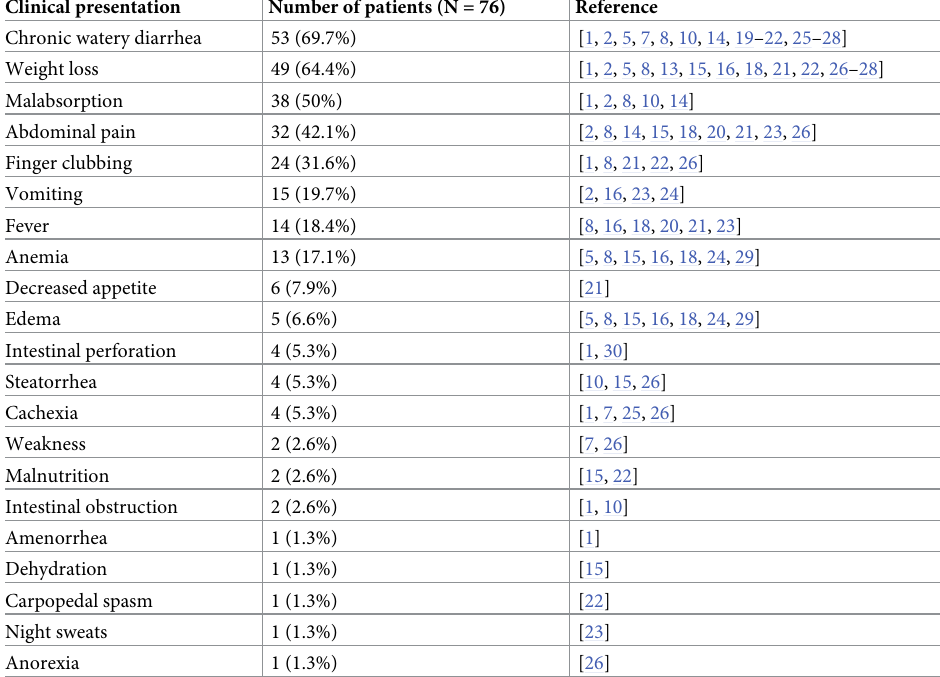
Table 2. Frequency reported for IPSID clinical